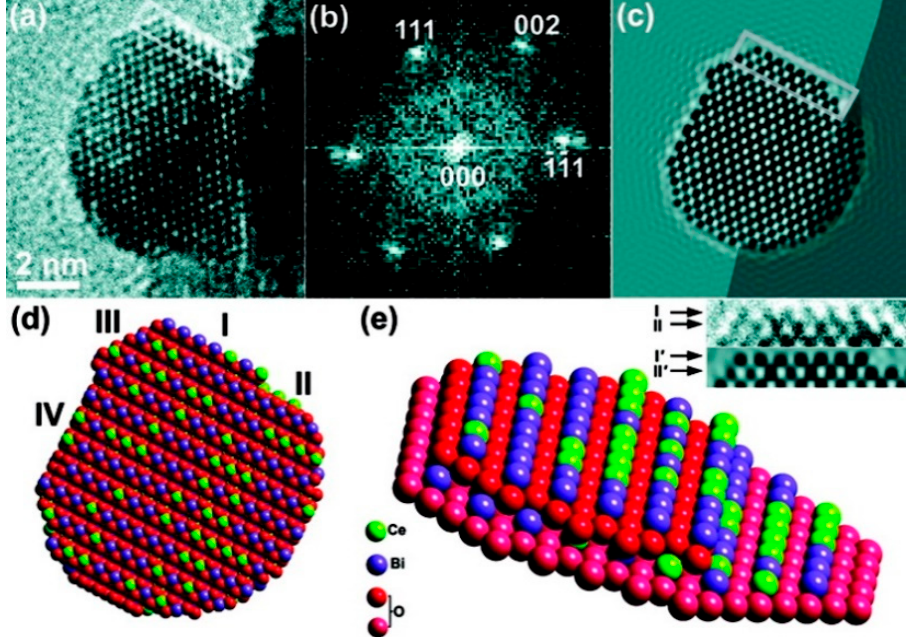
Figure 11. ( a ) High-resolution TEM image of a faceted crystallite of Ce 0.5 Bi 0.5 O 1.75 with one facet highlighted. ( b ) Indexed FFT obtained from the lattice image in Part ( a ). ( c ) A multislice image simulation produced for a similar fragment as in ( a ) with the same facet highlighted. ( d ) Faceted structure model used to produce the simulation in ( c ). I, II, III and IV indicate (002), (002) ′ , (111) and (220) facets, respectively, assigned relative to ( b ). ( e ) Schematic surface structure model showing the (002) step and (002) terrace. Insets are details from the corresponding lattice image (i.e., I and II) and simulation (i.e., I ′ and II ′ ). Surface oxygens are omitted for clarity [94]. Reprinted with permission from Sardar, K.; Playford, H.Y.; Darton, R.J.; Barney, E.R.; Hannon, A.C.; Tompsett, D.; Fisher, J.; Kashtiban, R.J.; Sloan, J.; Ramos, S.; Cibin, G.; Walton, R.I. Nanocrystalline Cerium − Bismuth Oxides: